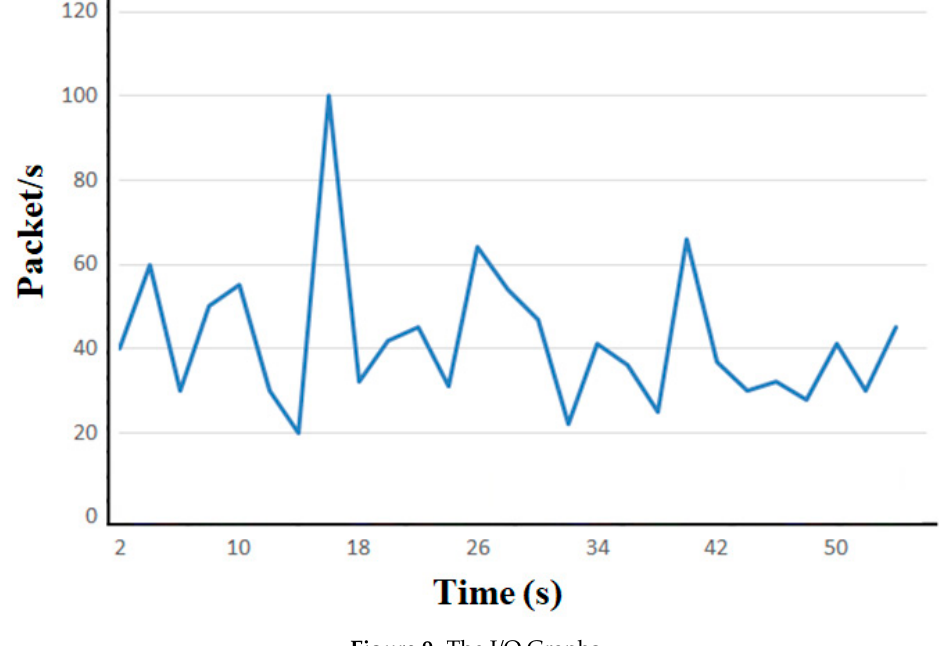
Figure 9. The I / O Graphs. Figure 9. The I/O Graphs.